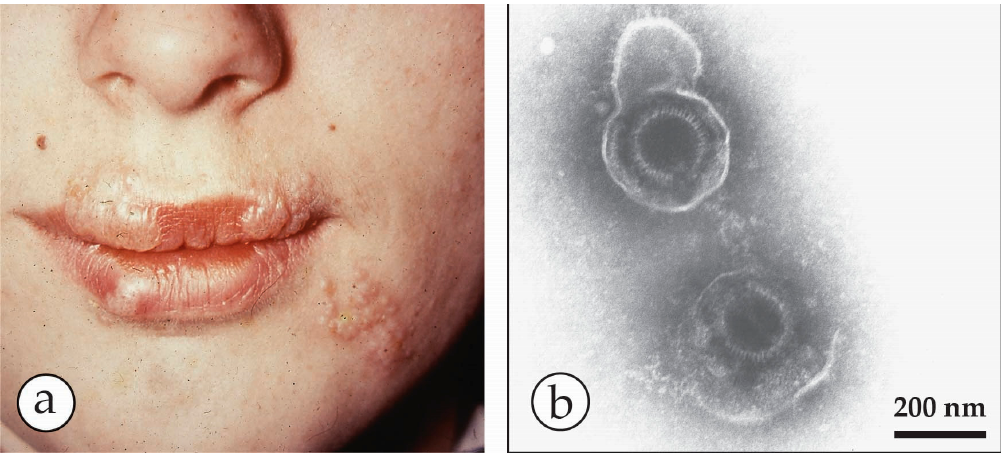
Figure 12. Herpes simplex eruption. ( a ) Severe herpes simplex eruptions on the lips and chin of a young woman. ( b ) Typical herpes virus particles seen after PTA NS of vesicle fluid. The labile envelopes are stain-penetrated and reveal the similarly stain-penetrated capsids. In the thinner stain, the upper virion also shows glycoprotein spikes in the periphery of its envelope.